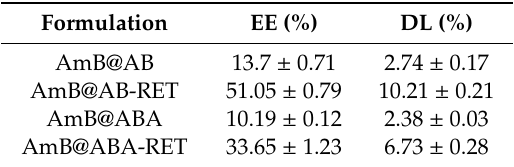
Table 3. Drug loading (DL) and encapsulation e ffi ciency (EE) obtained by analysis by UV-vis the lyophilized